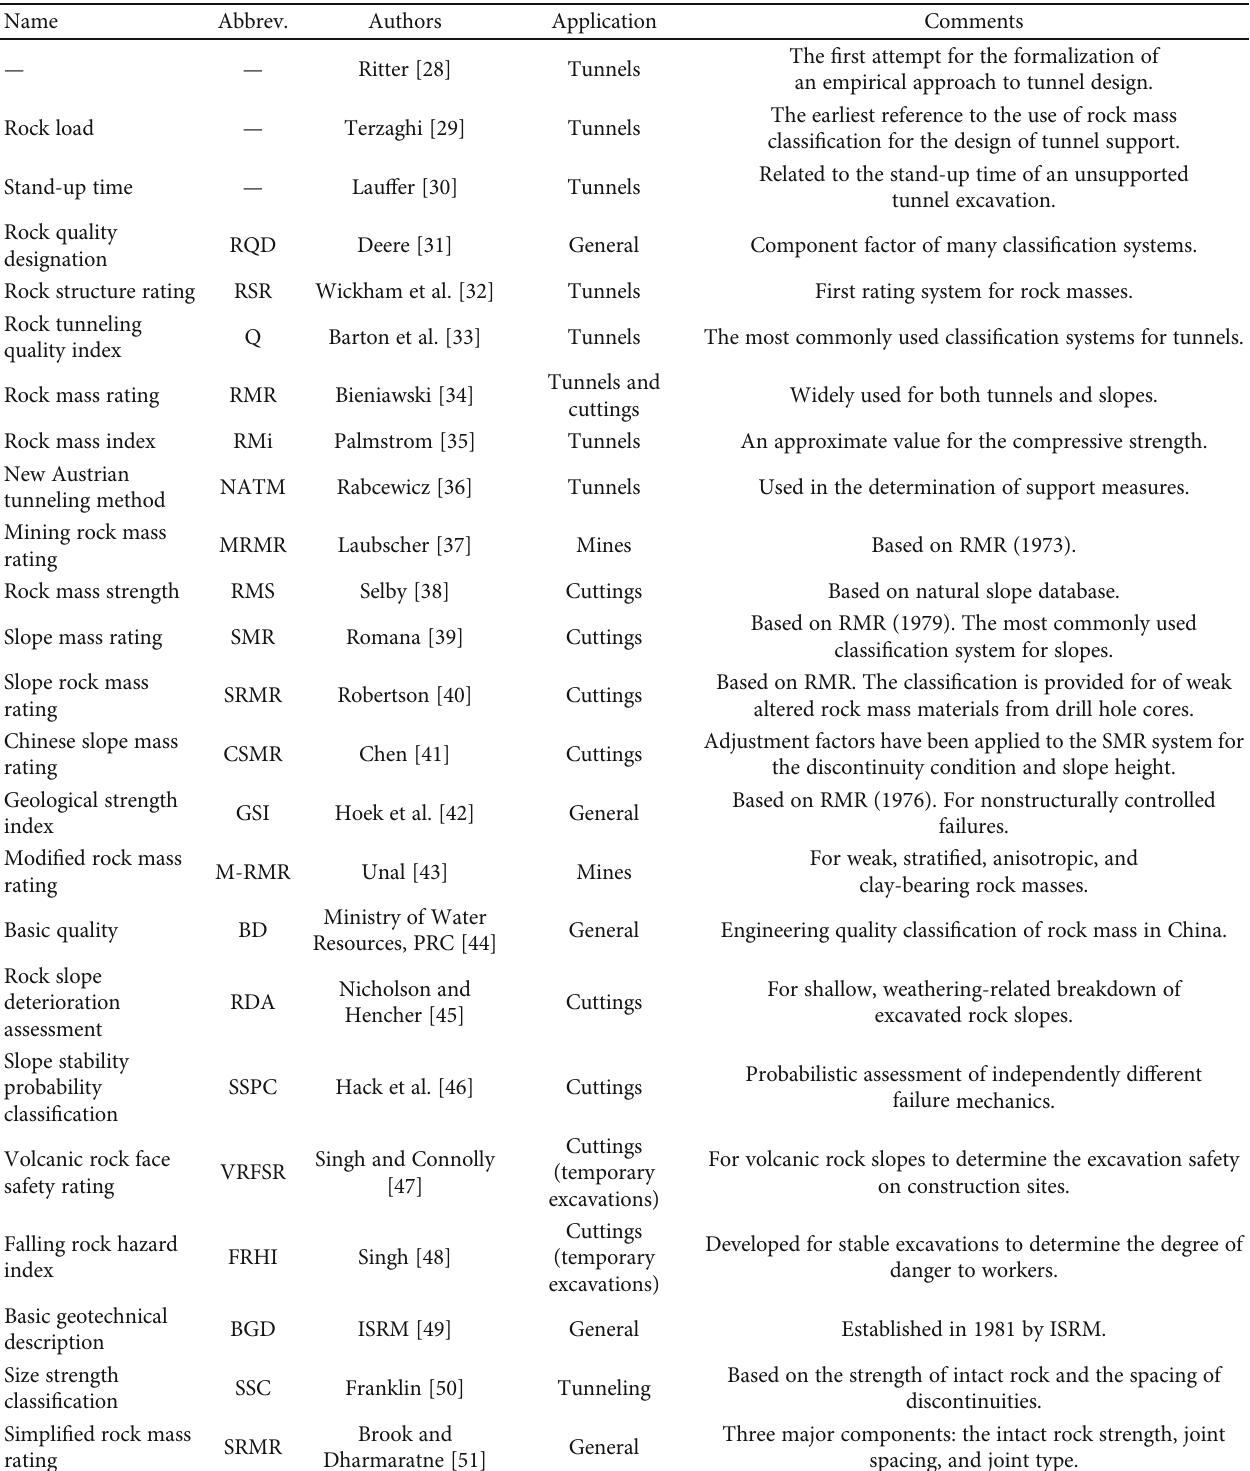
Table 1: Existing rock mass classi fi cation